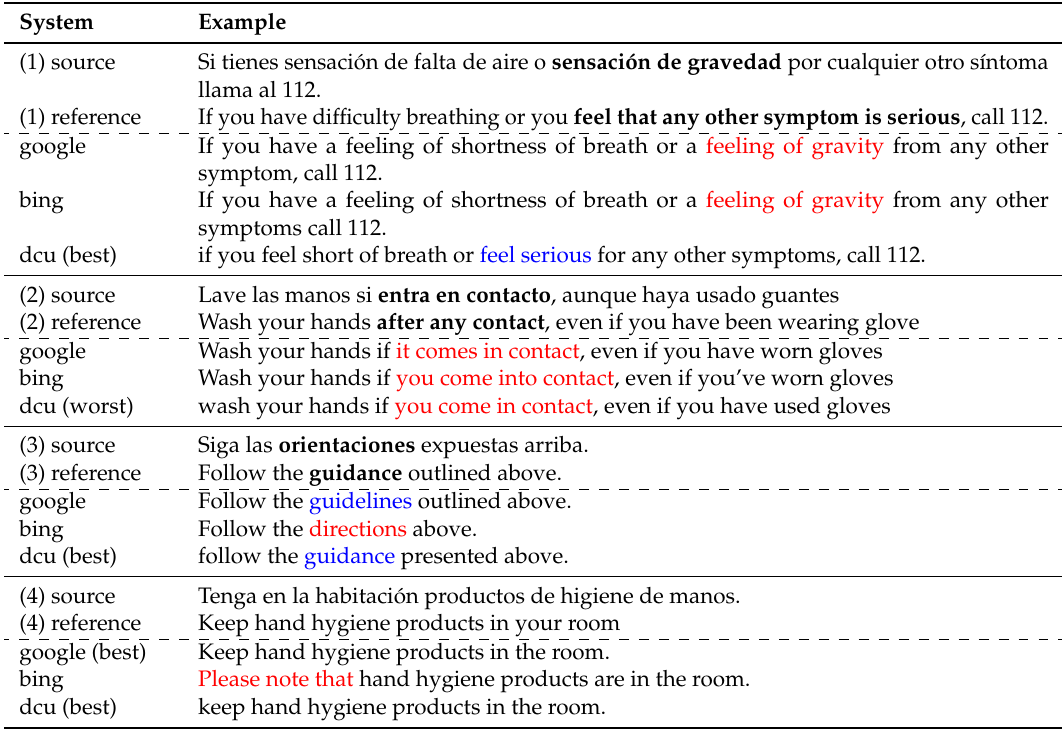
Table 11. Translation examples for